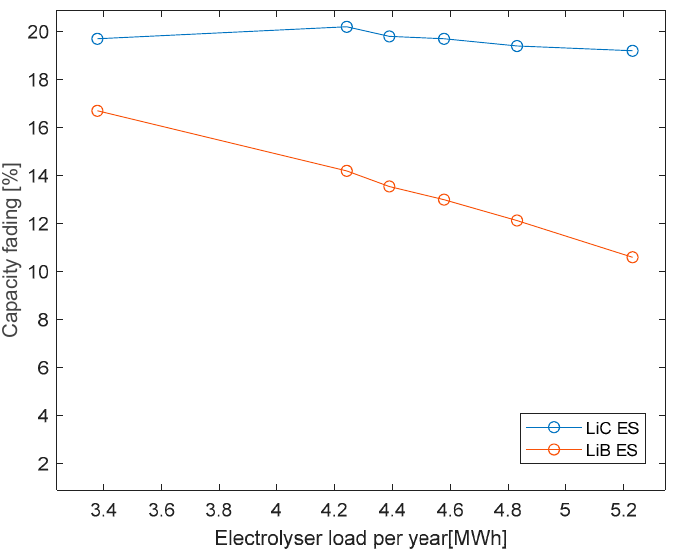
Figure 13. Capacity fade of the LiC and LiB ES as a function of the energy delivered to the electro- lyser load.